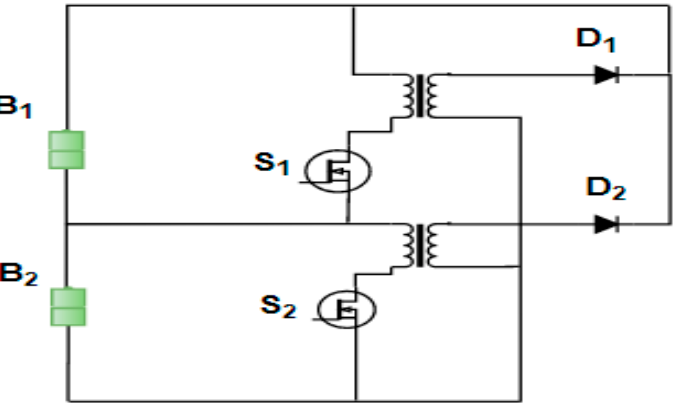
Figure 9. Active Flyback Based Balancing [22] .